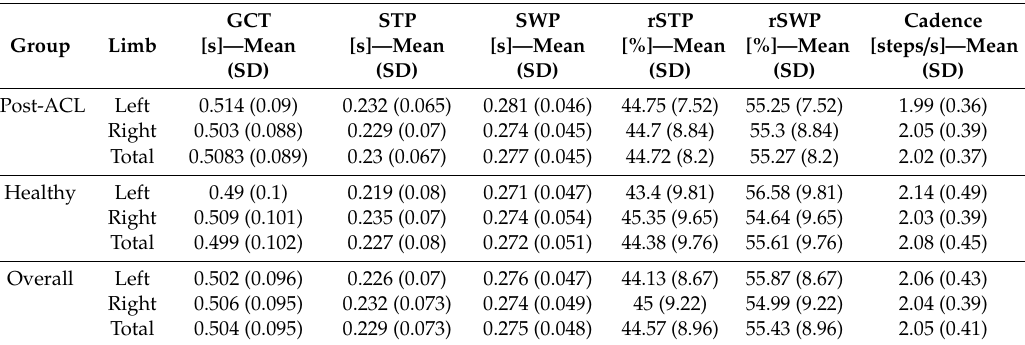
Table 2. Gait Temporal Parameters—Descriptive